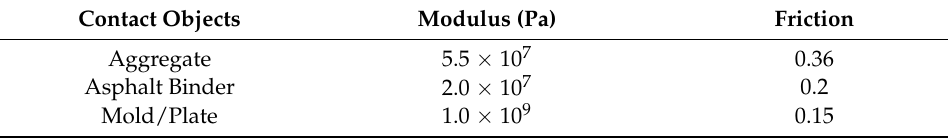
Figure 7. DEM simulation process: ( a ) stacked states by gravity; ( b ) compacted states after gyratory Table 7. Meso-parameters of DEM model. compaction.